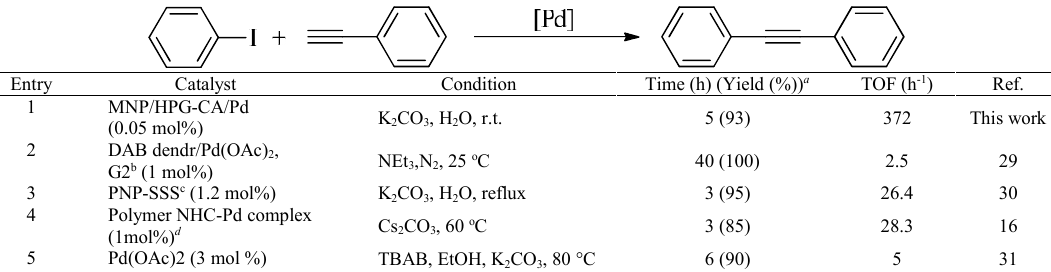
Table 7. Comparison of the results of Sonogashira coupling reactions catalyzed by MNP/HPG-CA/Pd and reported results with some other Pd catalysts